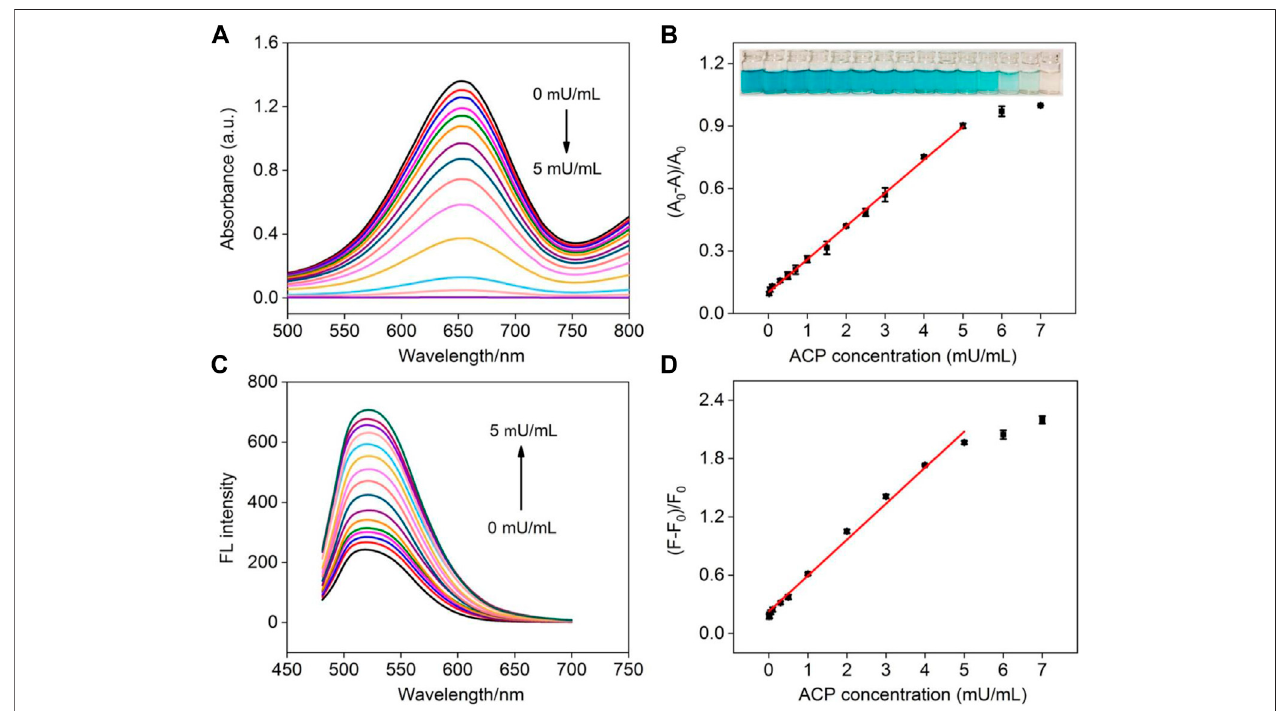
FIGURE 7 | (A) Absorbance spectra obtained in the mixture of NGQDs + H 2 O 2 + TMB in the presence of different concentrations of ACP (0 – 5 mU/ml). (B) Linear calibration plot for colorimetric detection of ACP. Insets are photographs of the corresponding solutions (from low to high concentrations of ACP). (C) The fl uorescence spectra of NGQDs obtained in the mixture of NGQDs + H 2 O 2 + TMB in the presence of different concentrations of ACP (0 – 5 mU/ml). (D) The linear calibration plot for ACP detection in fl uorescent